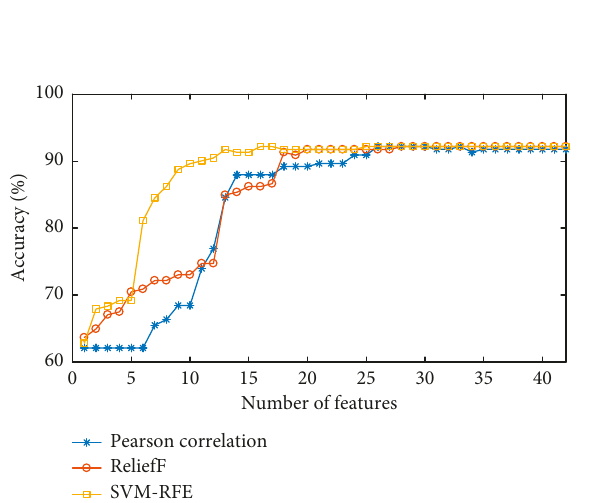
Figure 12: Classification accuracy as a function of the number of features.